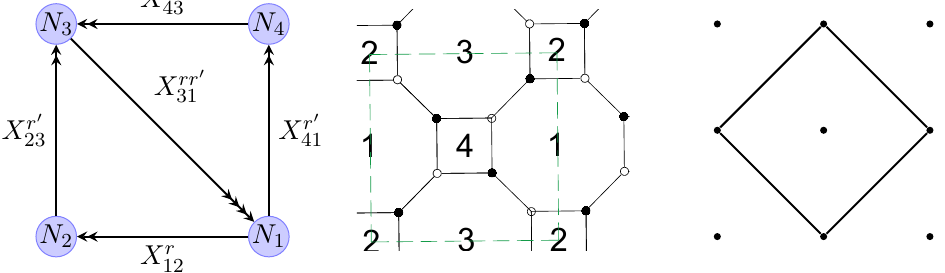
Figure 36. The quiver, the dimer and the toric diagram of the magnetic phase of the C = Z 0